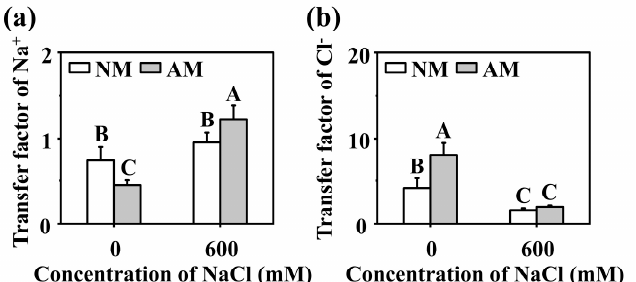
Figure 2. The transfer factor (TF) of Na + and Cl − in C. glauca under different treatments. ( a ) The TF of Na + in C. glauca . ( b ) The TF of Cl − in C. glauca . NM, nonmycorrhizal; AM, inoculated with R. irregularis ; 0, no NaCl stress; 600, 600 mM NaCl stress. The data are the means ± standard errors ( n = 3). Different capital letters indicate significant differences between means at the p < 0.05 level by Tukey’s test.